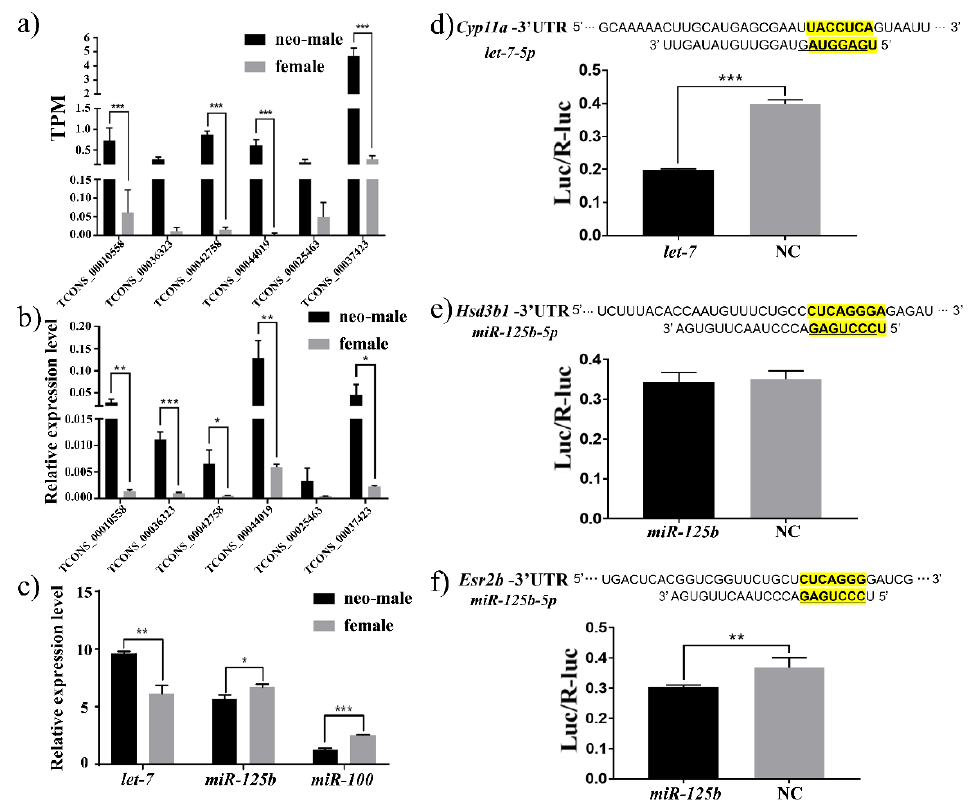
Figure 6. Functional investigation of let-7 / miR-125b cluster in gynogenetic P. olivaceus . Expression of six putative lncRNAs as let-7 precursors by ( a ) RNA-seq and ( b ) qRT-PCR; ( c ) expression of let-7 , miR-125b and miR-100 by qRT-PCR; dual-luciferase reporter analysis of let-7 targeting cyp11a ( d ) and miR-125b targeting hsd3b1 ( e ) and esr2b ( f ), with the bold yellow regions as the complementary target sites. Data are shown as mean ± SD ( n = 3). Asterisks indicate statistical significance between groups (* p < 0.05; ** p < 0.01; *** p < 0.001).